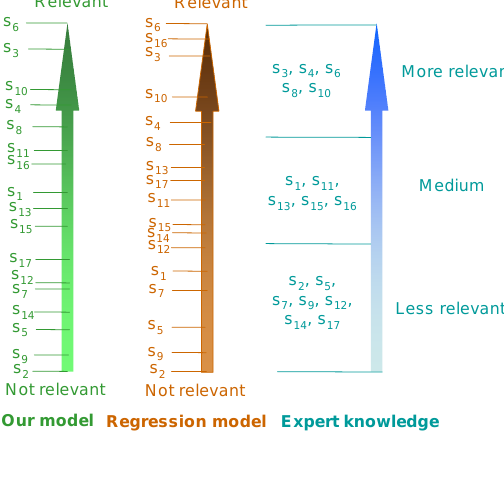
Fig. 5. Ranking list of all the